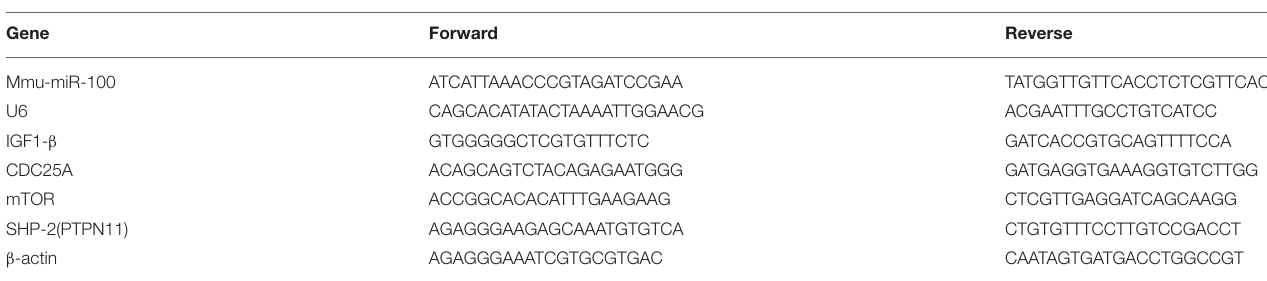
TABLE 2 | Primers sequences of qRT-PCR used in this